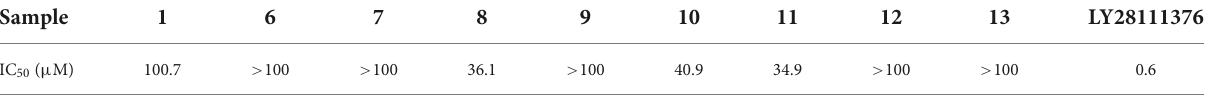
TABLE 3 β -amyloid precursor protein-cleaving enzyme 1 (BACE1) inhibitory tests of compounds 1 and 6 – 13 . Sample